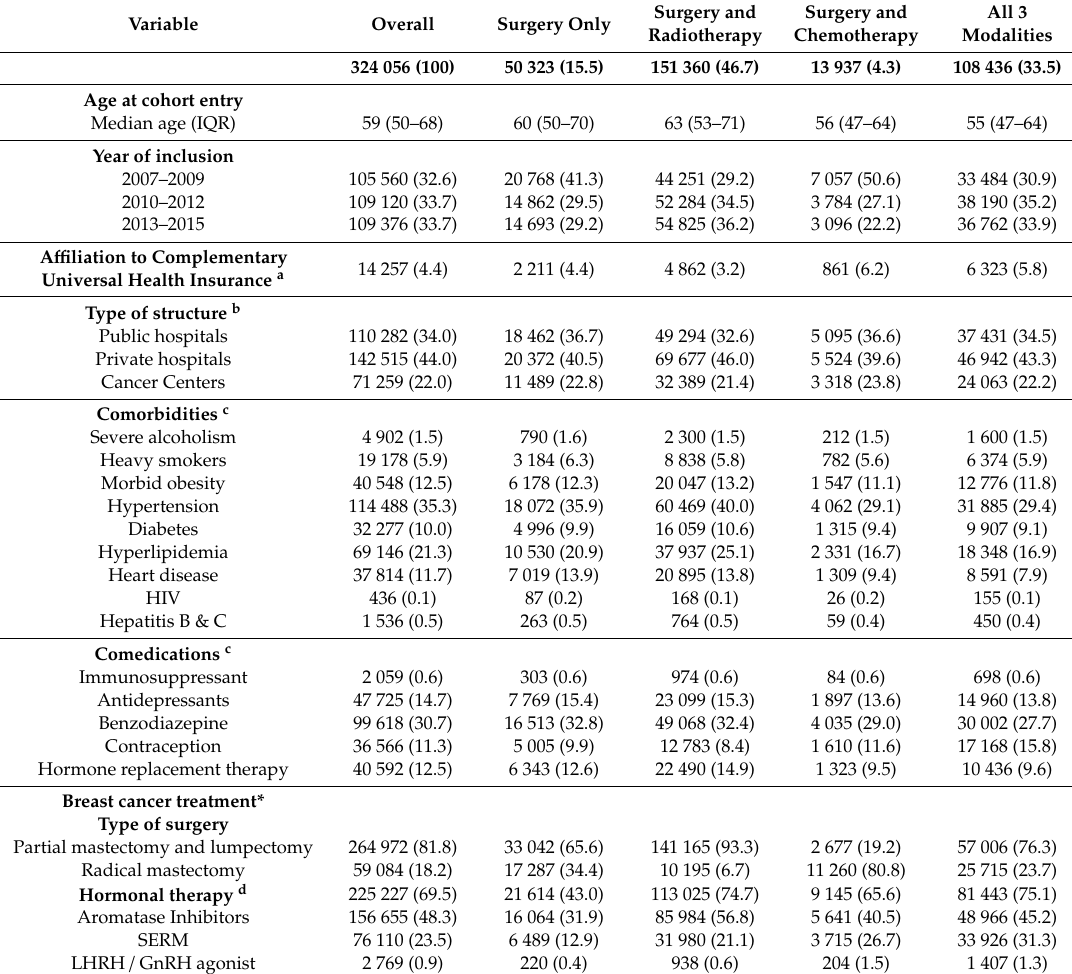
Table 1. Characteristics of the study